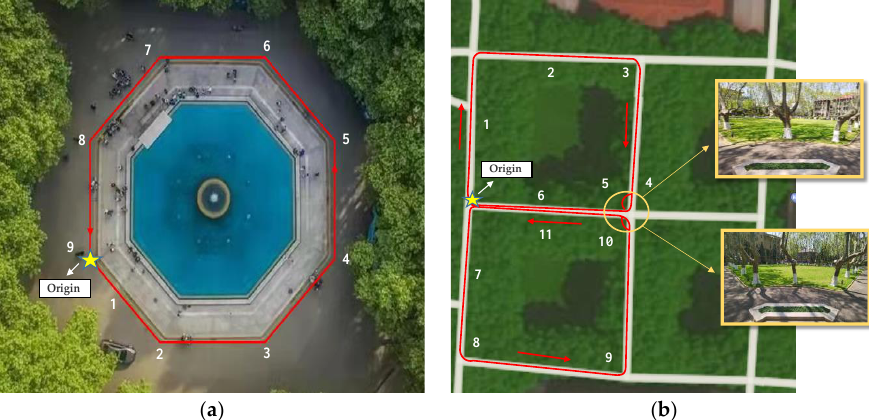
Figure 8. The experimental test scenarios. ( a ) The experimental environment of a fountain; ( b ) the experimental route under a shading environment.